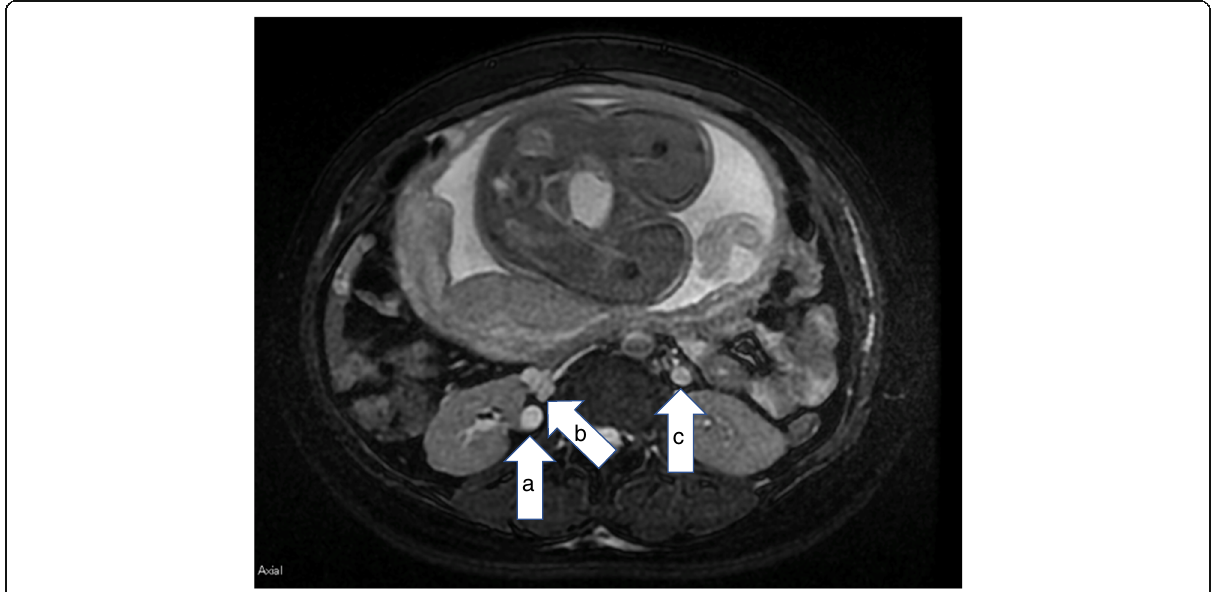
Fig. 1 Axial abdominal T2-weighted MRI. a Dilated right ureter. b Inferior vena cava. c Left ureter. Legend: the right ureter ( a ) traveled to the dorsal side of the inferior vena cava ( b ) and was compressed by an enlarged fetus, causing hydronephrosis. The dilation of the left ureter ( c ) was less than that observed in a and is a physiological change seen in pregnant